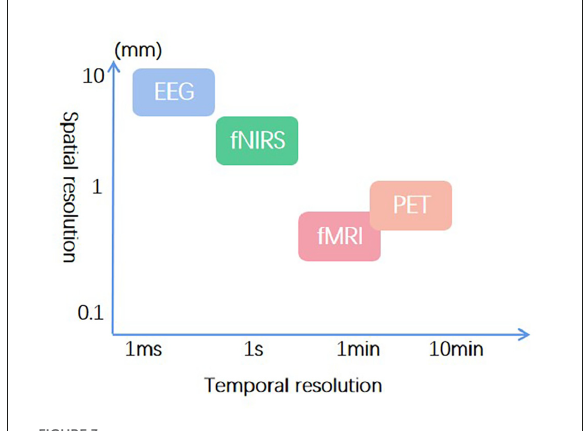
FIGURE3 Temporal and spatial resolution of frequently used neuroimaging techniques in acupuncture